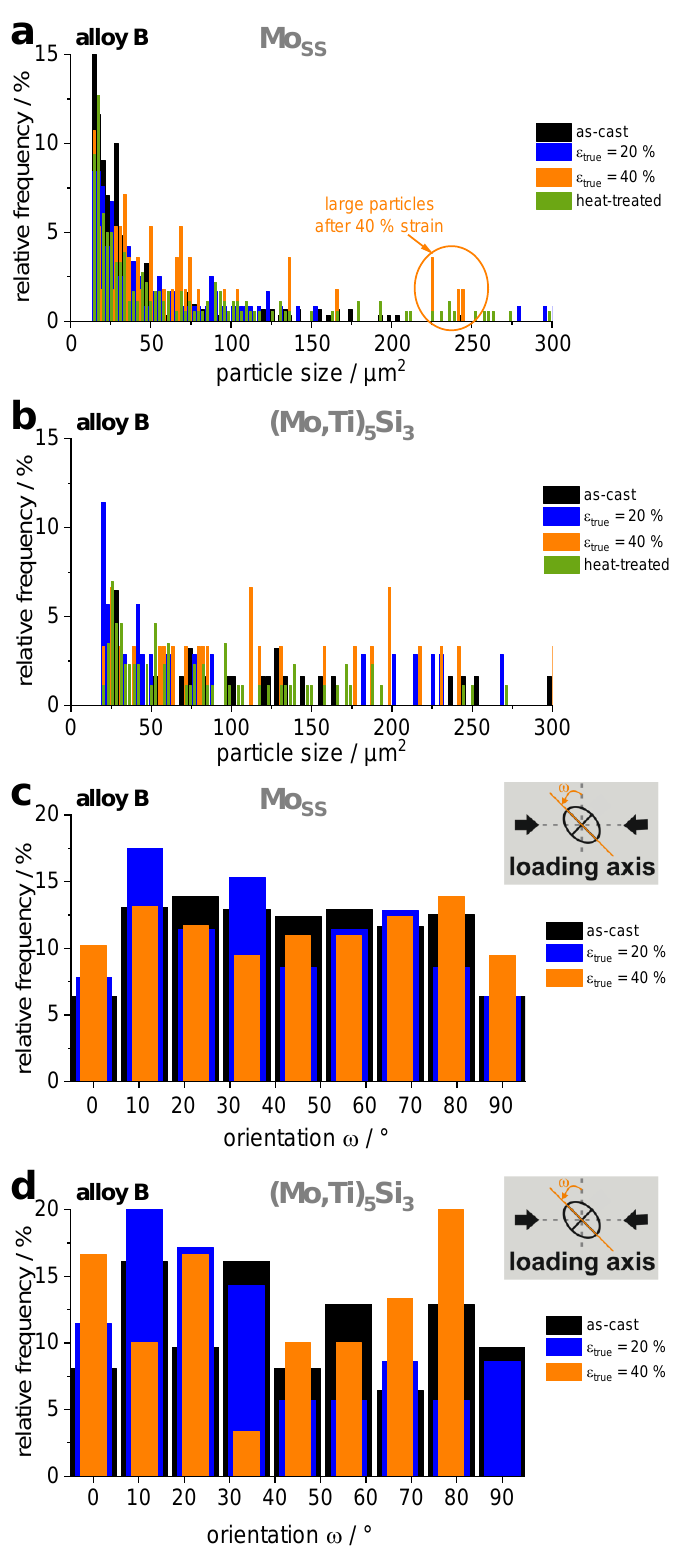
Figure 10. Particle size distribution of Mo SS ( a ) and (Mo,Ti) 5 Si 3 particles ( b ) and their orientation ( c , d ) (particle shape approximated as ellipse) in alloy B in as-cast condition and after compressive creep testing at 1200 °C, 200 MPa up to a true compressive strain of 20 and 40% in comparison to heat-treated samples at 1200 °C for 100 h.